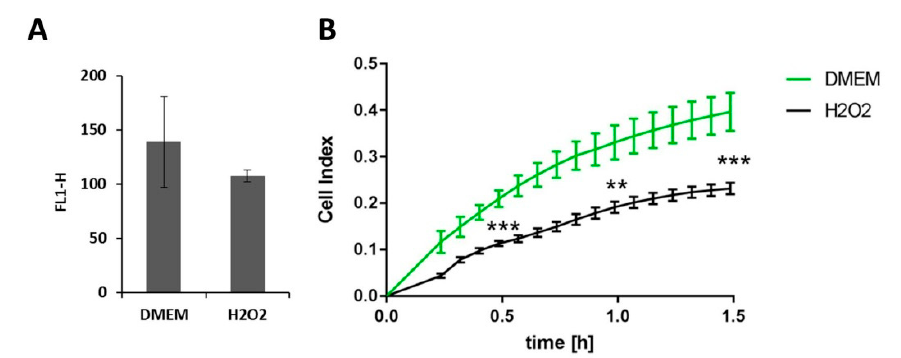
Figure 6. Influence of hydrogen peroxide on HaCaT cells in DMEM. ( A ) Flow cytometry determination of the HA expression in non-adherent HaCaT cells after cultivation in H2O2 or DMEM for 3 h (mean ± s.e.m., n = 2). ( B ) Online monitoring of HaCaT cell adhesion in H2O2 and DMEM up to 1.5 h. Note that both the HA pericellular coat and the adhesion of the cells were impaired by H2O2 (xCELLigence Real-time Cell Analysis, normalized cell index; mean ± s.e.m., n = 3, Mann–Whitney test, ** p < 0.01, *** p < 0.001 DMEM vs. H2O2). Abbr.: FL1-H: fluorescence intensity, DMEM: